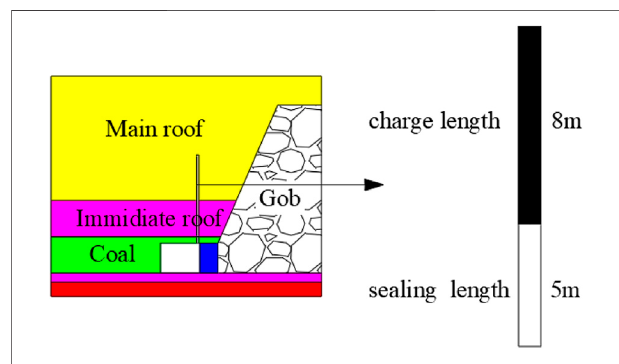
FIGURE 16 | Design of roof